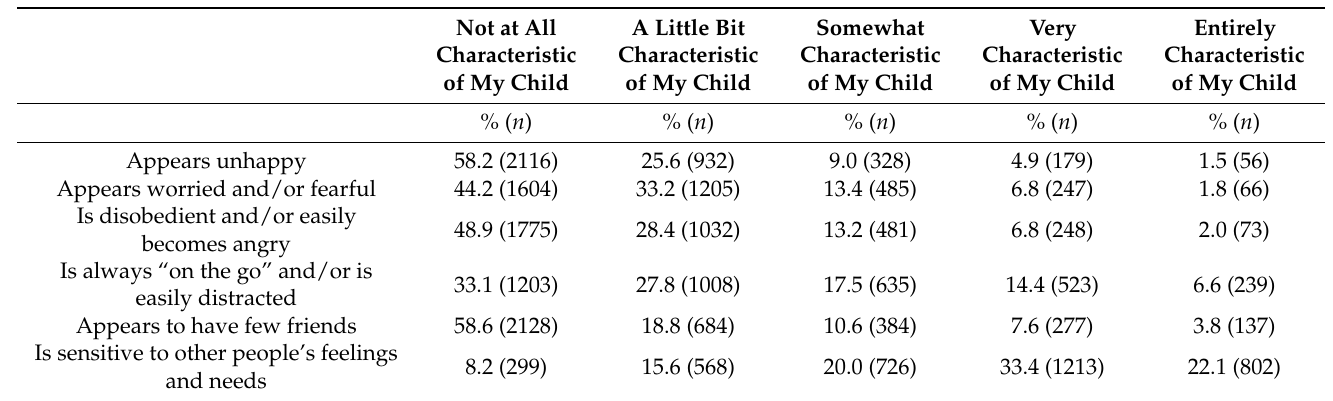
Entirely Very Characteristic Characteristic of My Child of My Child